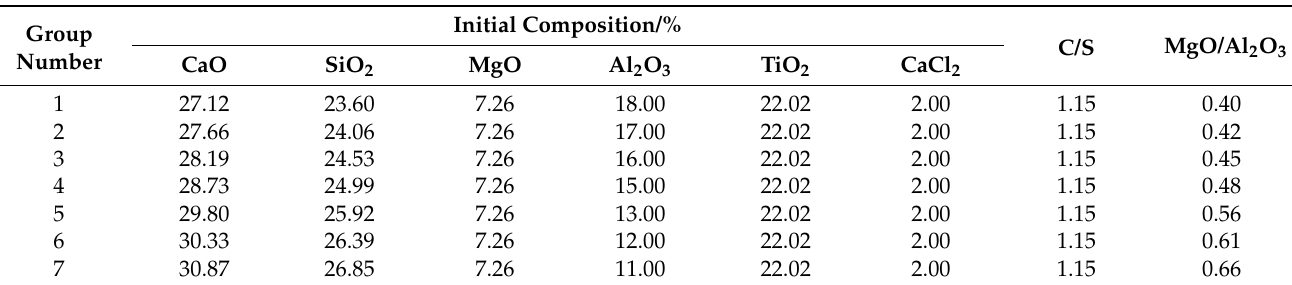
Table 2. Composition ratio of chlorine-containing high-titanium slag.